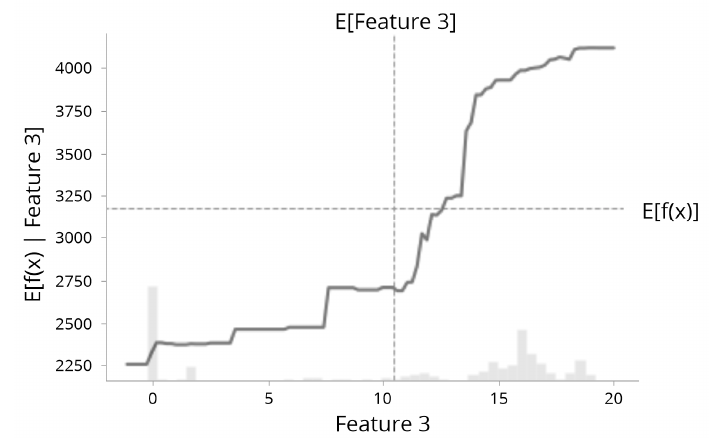
Figure 4. SHAP partial dependence plot illustration.